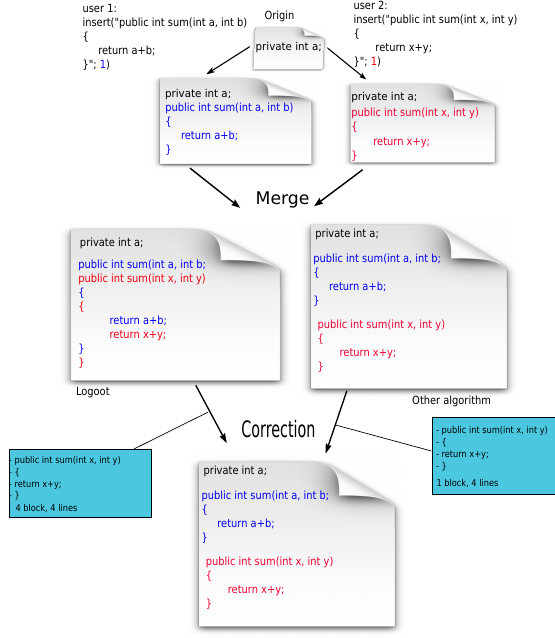
Figure 10. Different merge in operation-based approaches